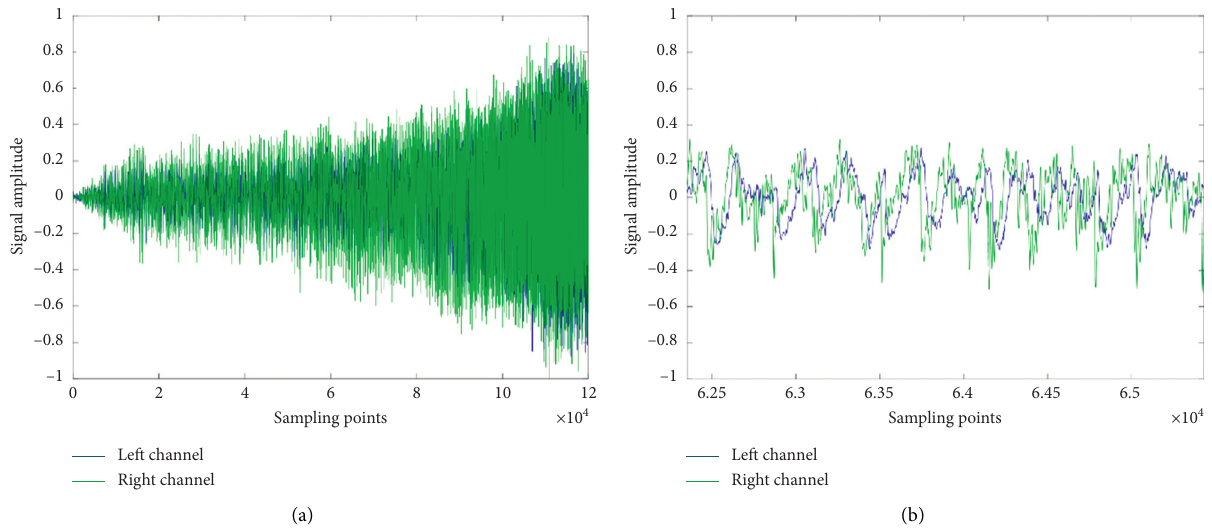
Figure 4: A dual-channel signal waveform of engine shipping noise recorded at East Sicily: (a) complete waveform and (b) a certain part of this